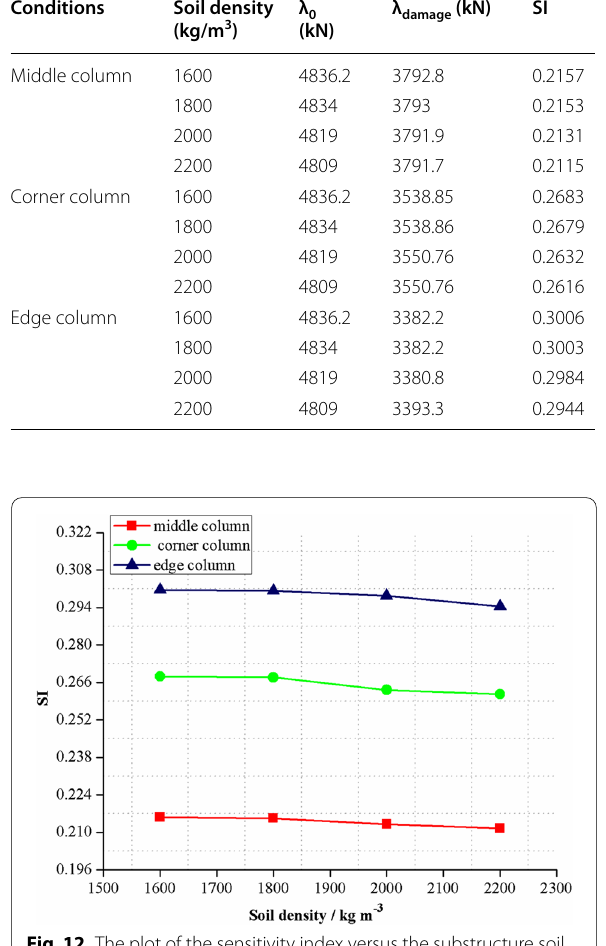
Fig. 12 The plot of the sensitivity index versus the substructure soil density.